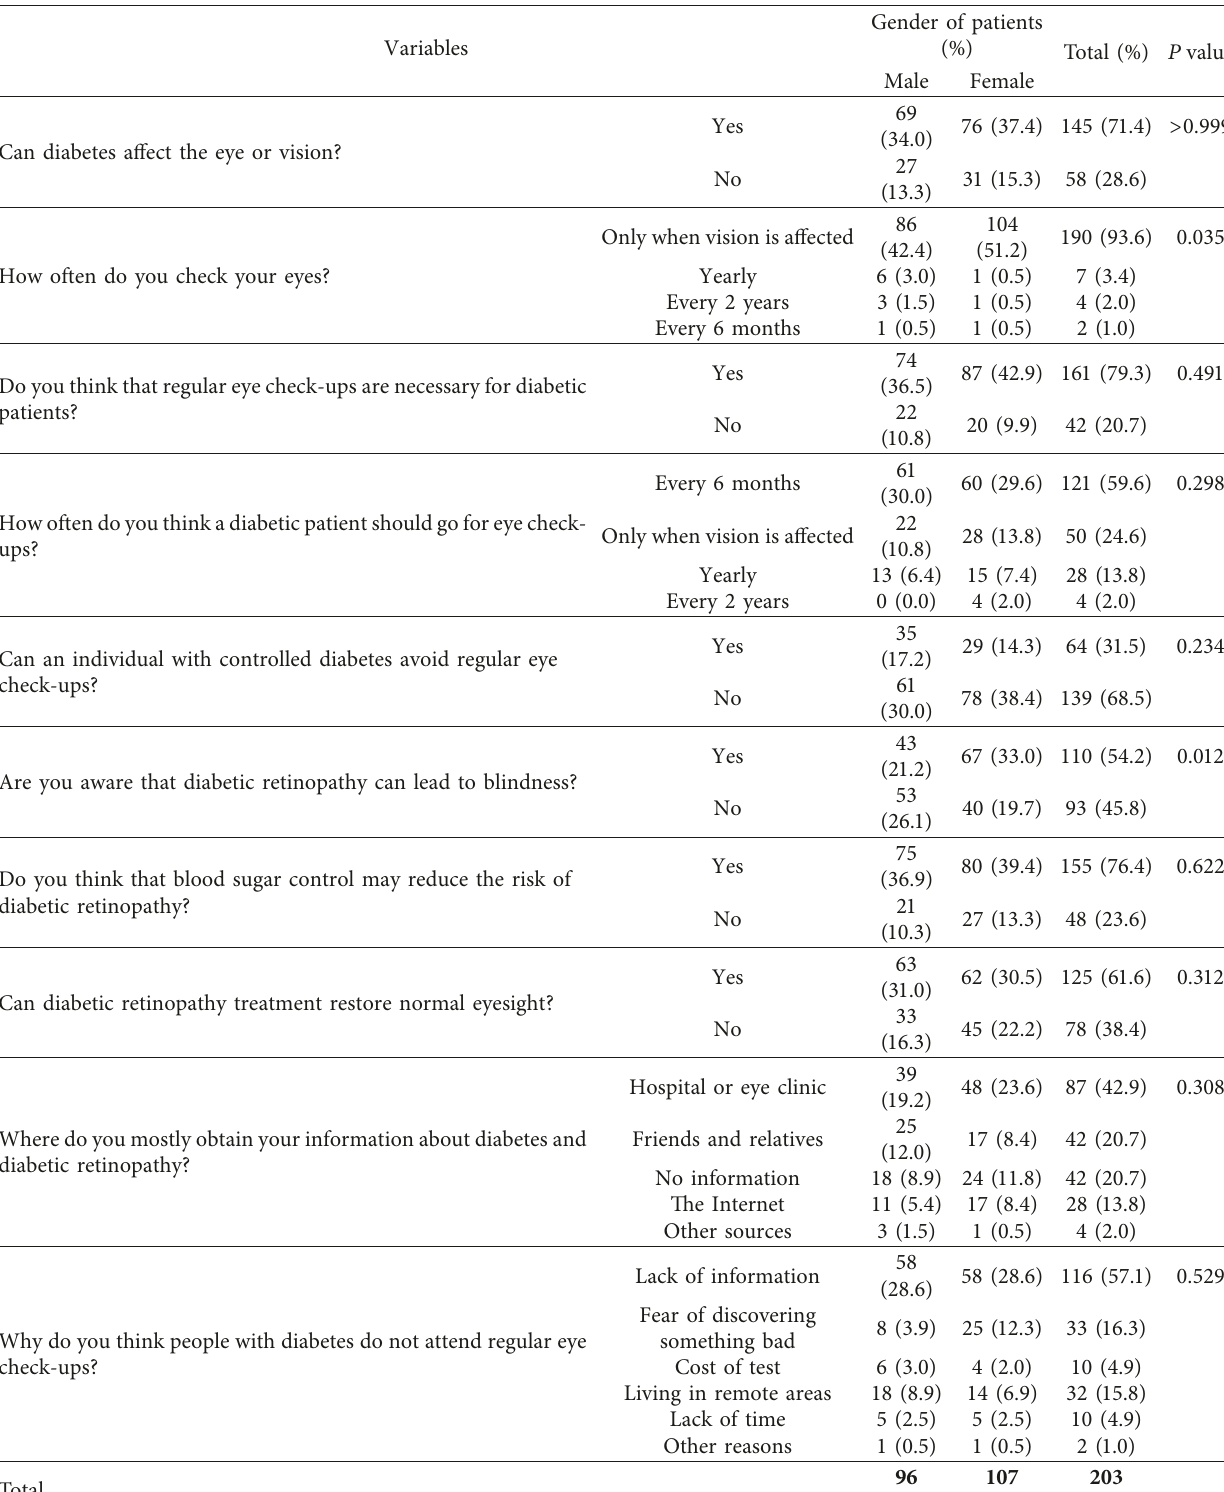
Table 1: Association between gender and knowledge and awareness of DM and